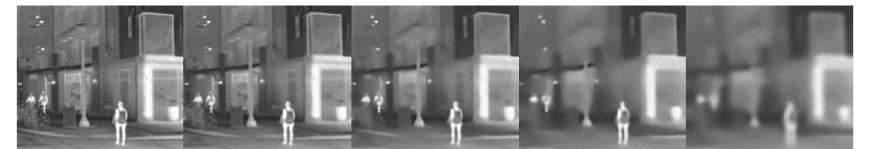
Figure 2: Iterative smoothness with RGF (mean value—guided filter).